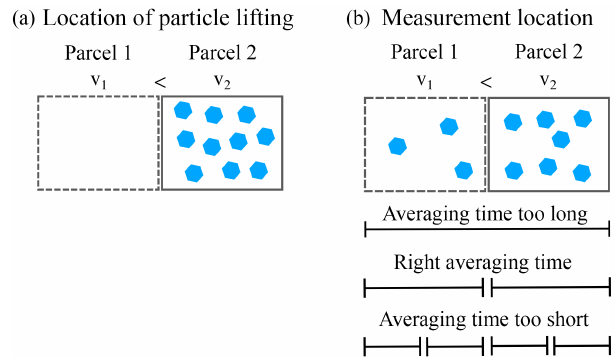
Figure 17. Illustration of the challenges of observing the wind de- pendence of blowing snow (Sect. 4.2). The two squares represent two air parcels with a duration (cid:49)t of 10–15s, which is typical for a gust. Parcel 2 represents a gust with a higher wind speed v 2 than the average wind speed v 1 in parcel 1. At the location of particle lofting (a) ice crystals are lofted due to the high turbulence in air parcel 2. On the way to the measurement location (b) some of the ice crys- tals were transported to the other air parcel, e.g., by sedimentation or turbulence. Also, the effect of different averaging times is illus- trated (b)